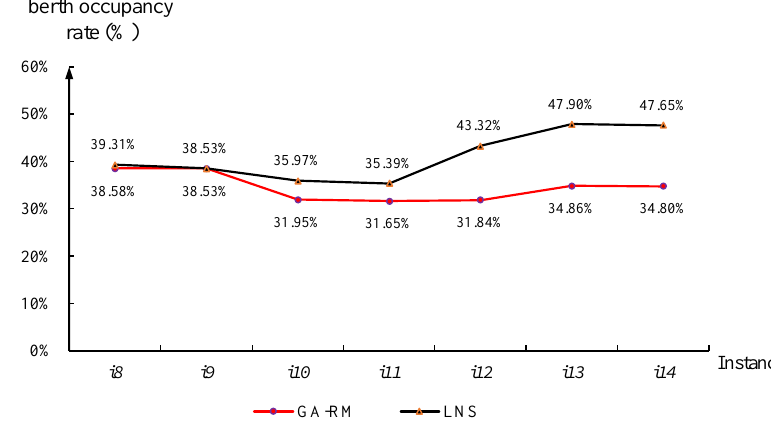
Figure 7. Comparison of the berth occupancy rate of the LNS and